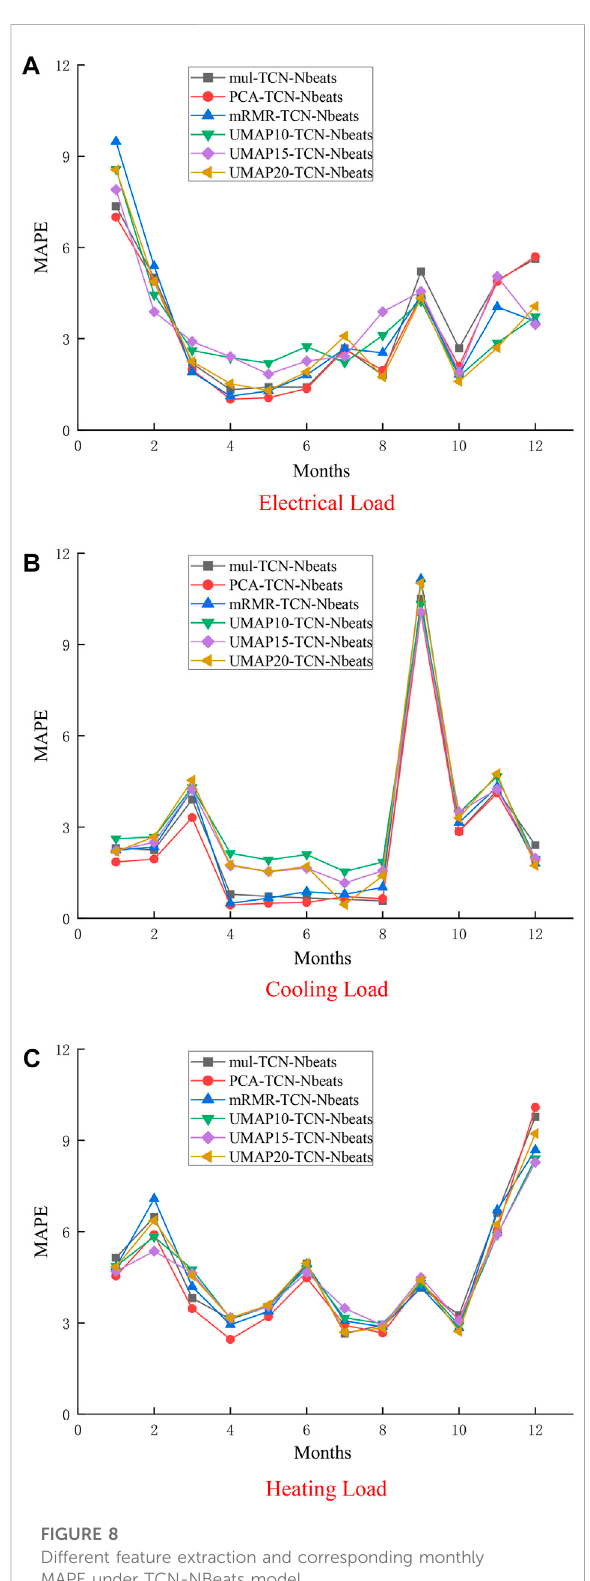
FIGURE 8 Different feature extraction and corresponding monthly MAPE under TCN-NBeats